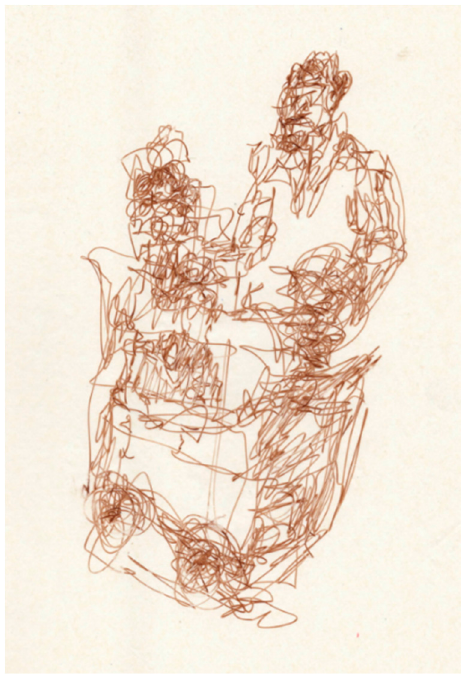
Figure 2. Man playing an Orgue de Barbarie , ink drawing by Seymour Simmons, 2018. In this gesture drawing, which took about 5 min, the instrument being played is a hand-cranked, mechanical music box. The non-stop lines were inspired by the rapid rhythm of the music and also sought to capture the equally rapid movement of the arms: the left arm turning the crank, the right arm feeding the string of punch-cards containing the score into the music box.